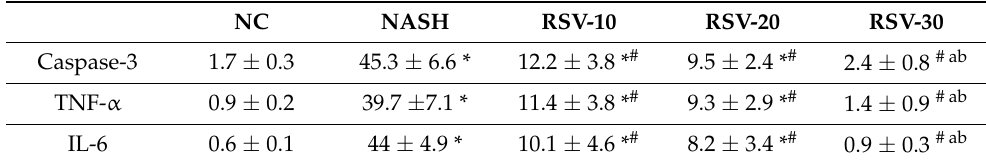
Table 2. The effect of rosavin on the mean area % of Caspase-3, TNF- α and IL-6